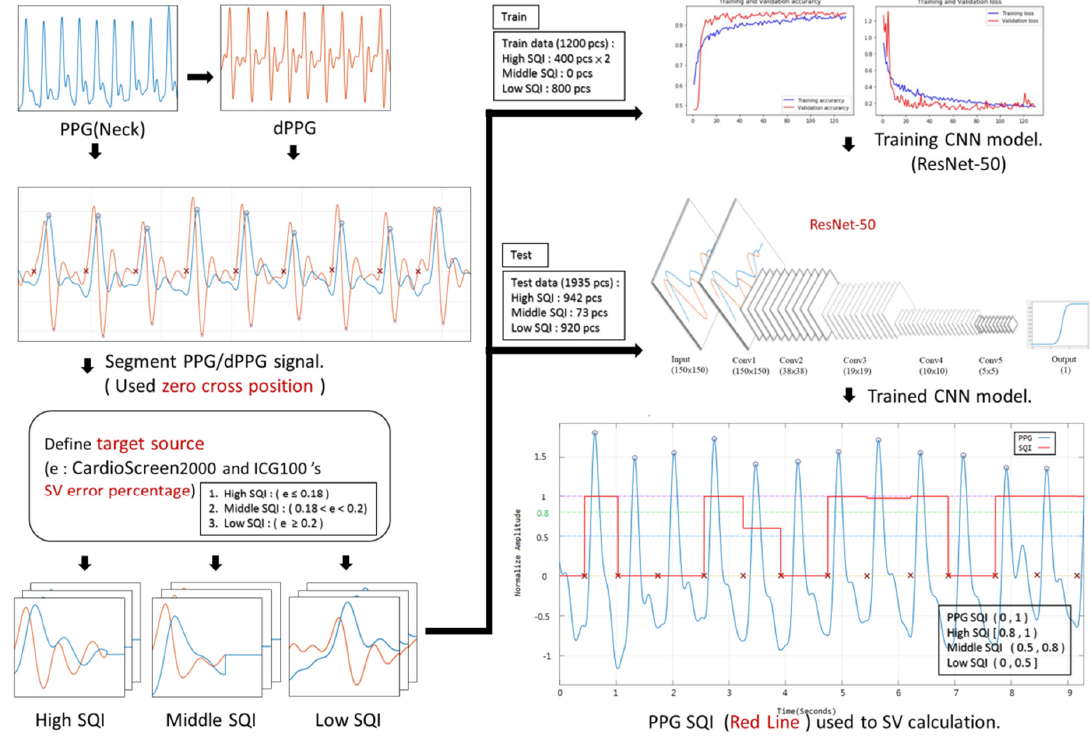
Figure 4. Overall procedure for signal quality index (SQI) classification of PPG pulses.